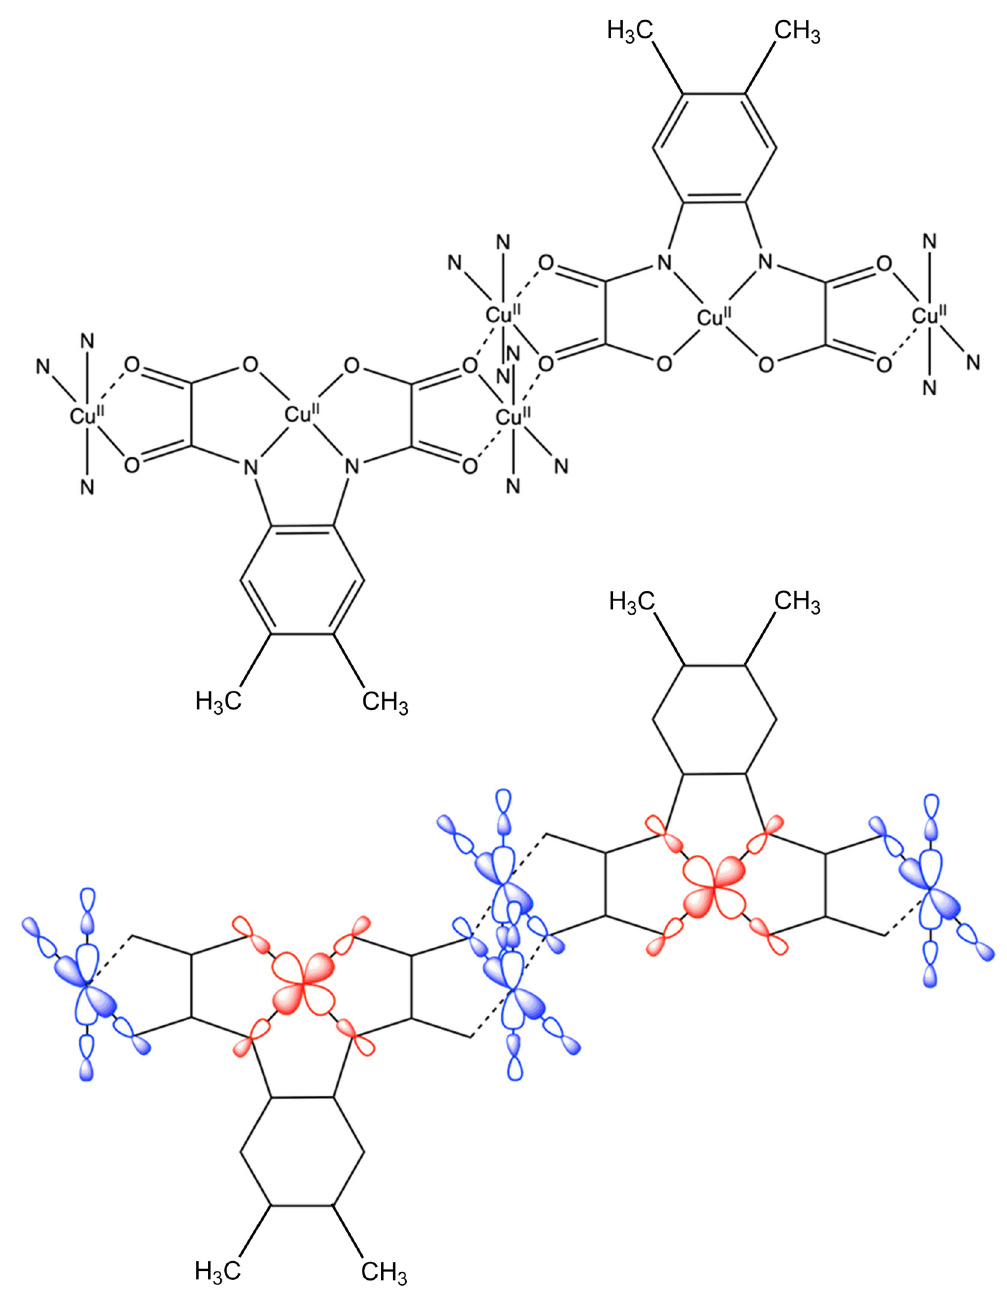
Scheme 3. Illustration of the orbital exchange pathway in 1 showing the nature and orientation of the magnetic orbitals of the copper(II) ions. The bpca blocking ligands are not shown for clarity. The solid and dashed lines represent short and long metal–ligand bonds.